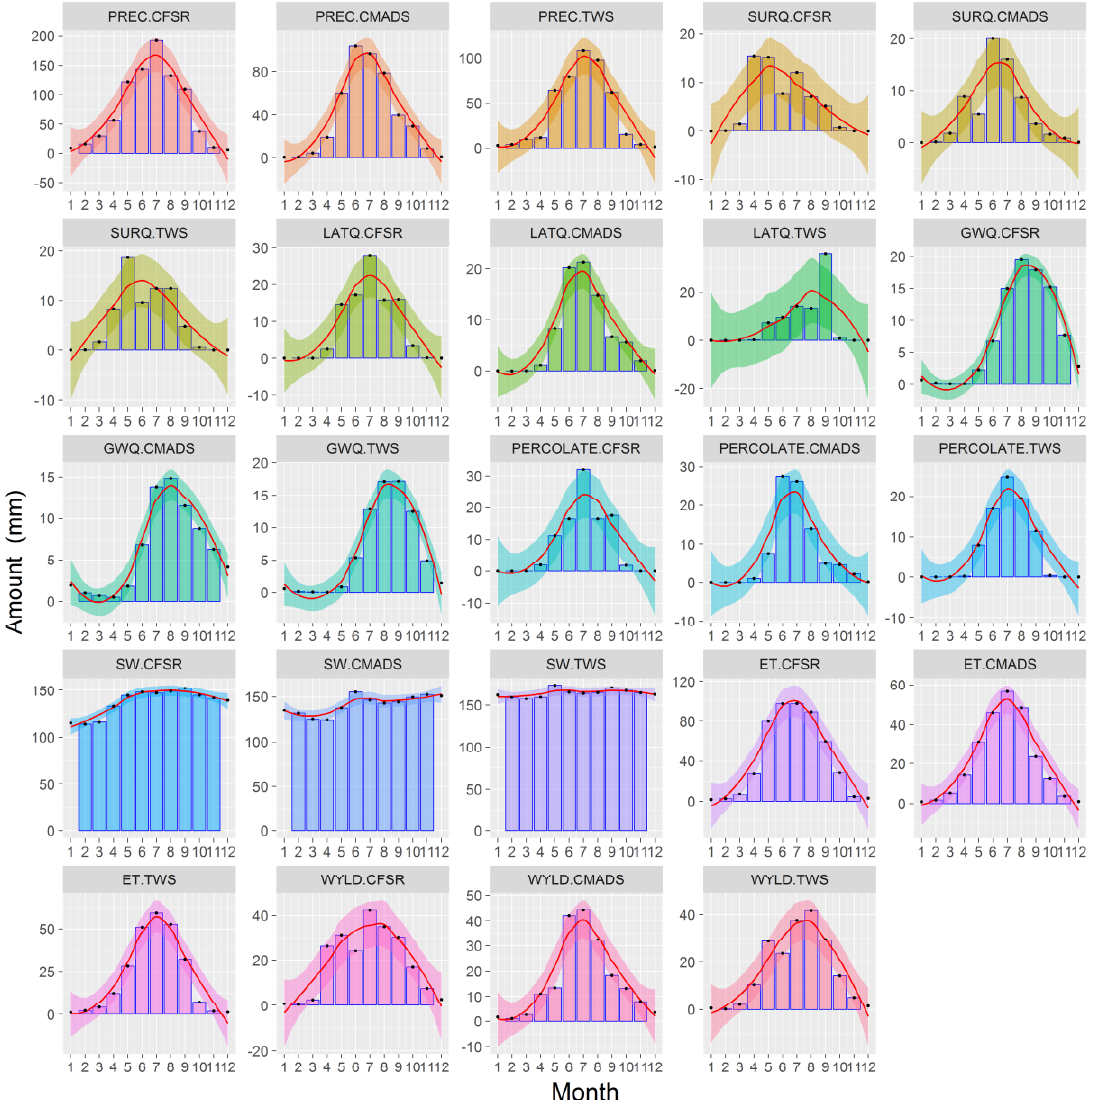
Figure 14. Seasonal Water balance chart in Heihe River Basin (HRB) of the three modes (TWS + SWAT, CFSR + SWAT and CMADS + SWAT), where PREC, SURQ, LATQ, GWQ, PERCOLATE, SW, ET, and WYLD represent precipitation, surface runoff, lateral flow, return flow, percolation to shallow aquifer, soil water, evaporation and transpiration, and water yield, respectively.